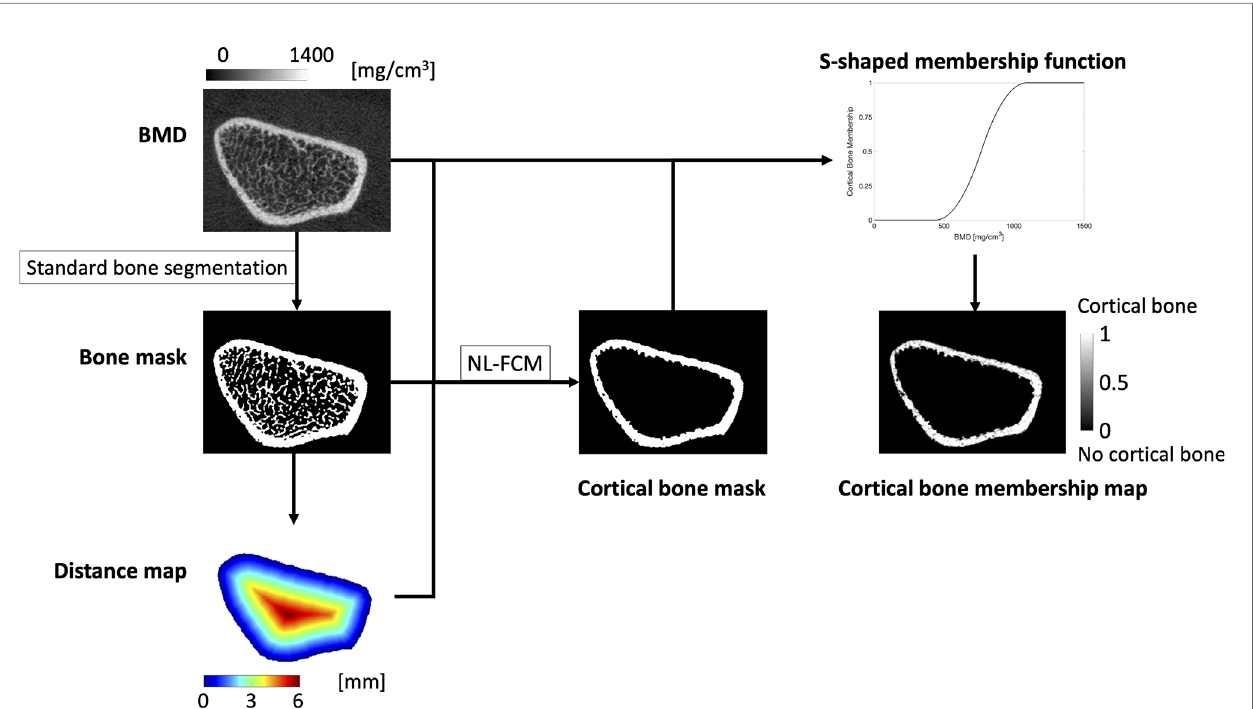
FIGURE 2 | The standard bone segmentation provided by the manufacturer was used to generate a bone mask. The periosteal surface was then used to compute a distance map, that together with the BMD map and the bone mask was fed to a non-local fuzzy c-means clustering algorithm (NL-FCM) to identify the endosteal surface. BMD values within the cortex were used to generate a s-shaped membership function that mapped each BMD value to a value between 0 and 1, indicating the degree of membership of each voxel to the category of cortical